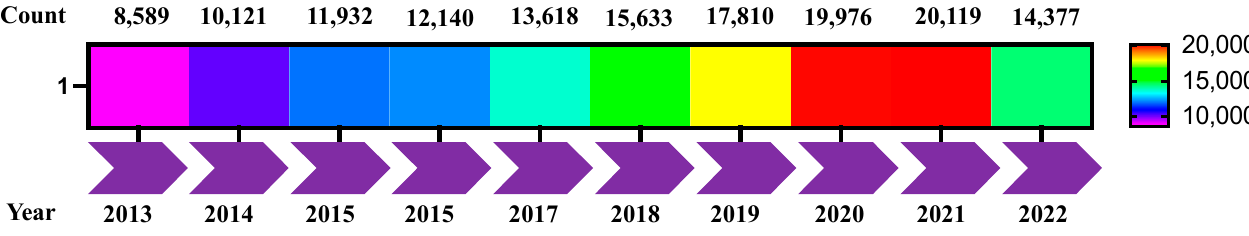
Figure 1. Number of miRNA related publications in the past ten years (data obtained from Pub- Med).